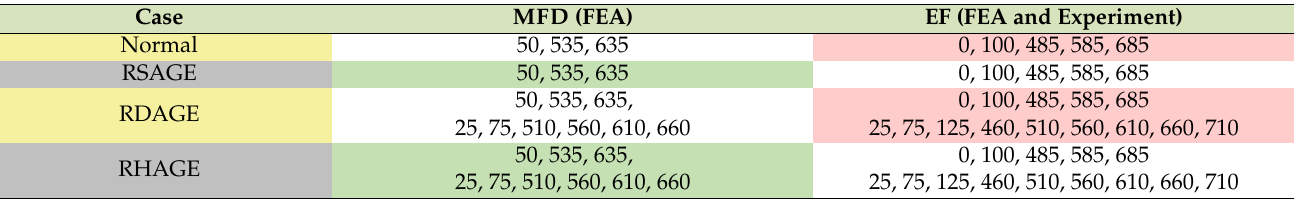
Table 3. Frequency components of MFD, EF before and after RAGE fault (FEA and